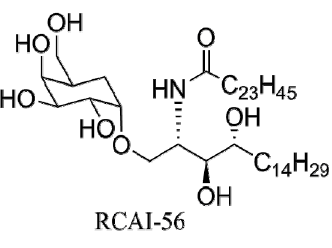
Figure 8. Carbocyclic analogs of α